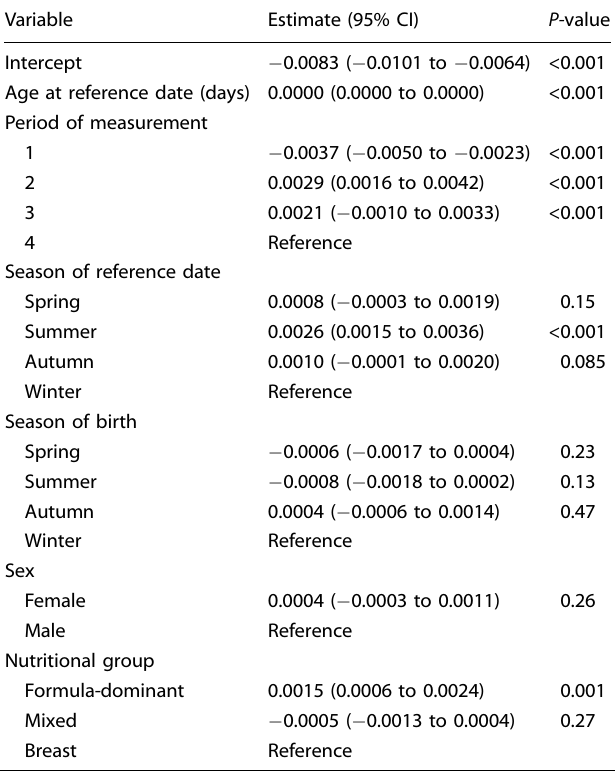
Table 2. Multilevel linear regression analysis of Δ LAZ/day.